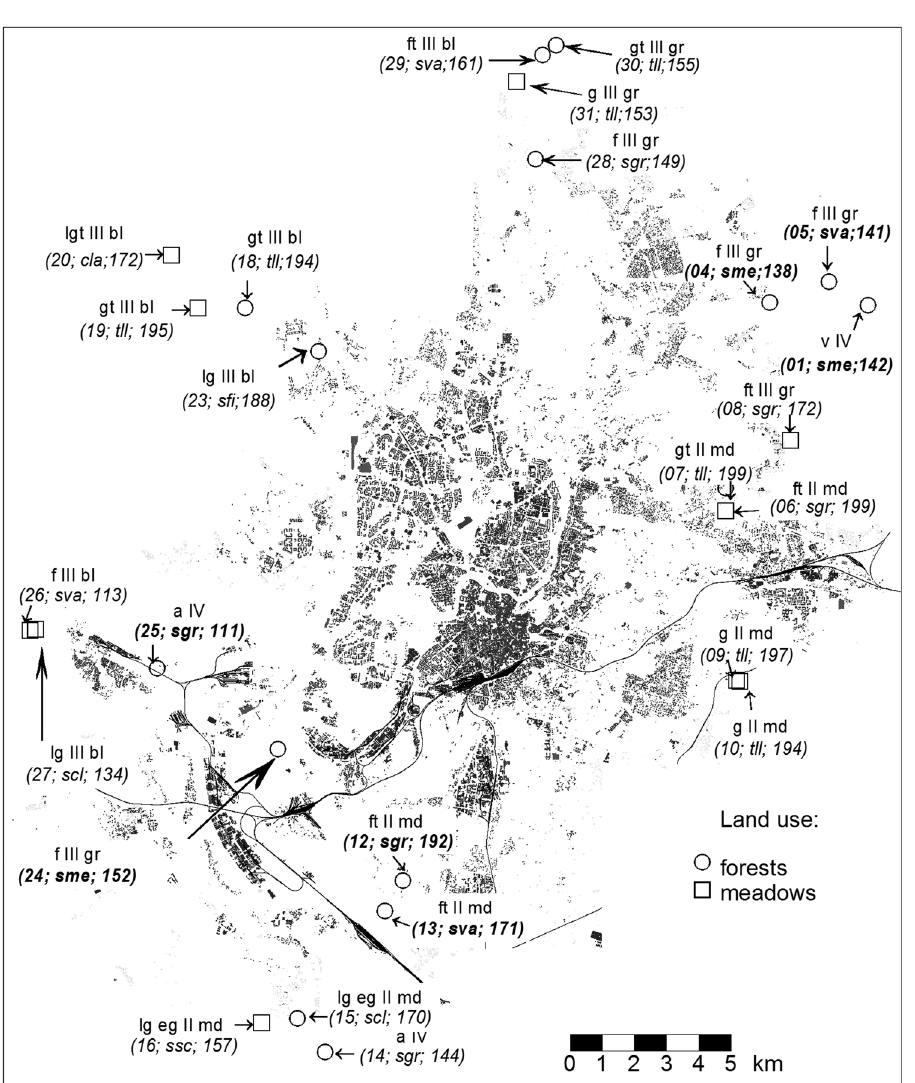
Figure 1: Location of soil sampling sites in peri - urban part of Vilnius and information about the underlying Quaternary deposits, relief elevation and land use. Information on Quaternary deposits was taken from the Lithuanian Geological Survey [ 17 ] . The index in the upper row indicates their origin and age. Origin: lg – proglacial glaciolacustrine, lgt – marginal glaciolacustrine, lg eg – englacial glaciolacustrine, g – basal till, gt – marginal till, f – proglacial glacio fl uvial, ft – marginal glacio fl uvial, a – alluvial, v – aeolian. Age: II md – Middle Pleistocene Medininkai, III gr – Late Pleistocene Gr ū da, III bl – Late Pleistocene Baltija and IV – Holocene. The lower row contains site ID, lithology of deposits and relief elevation ( m ) . Lithology: cla – clay; tll – till; di ff erent types of sand, i.e. ssc – silty - clayey, scl – clayey, s fi – fi ne, sme – medium, sva – various and sgr – gravelly. The lower row is in boldface when no information about soil type and lithology ( texture ) is available in the soil database [ 18 ]